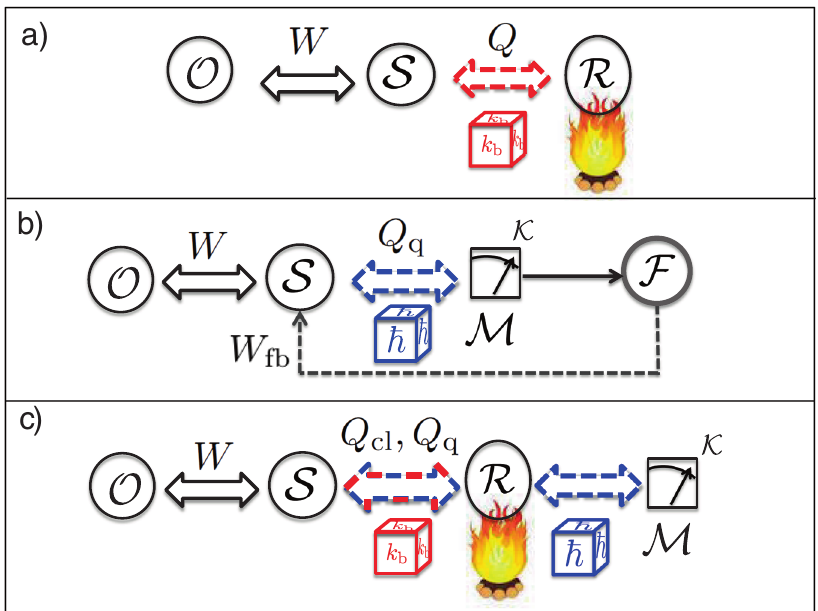
Fig. 1 a The scenery of thermodynamics: A system S deterministically exchanges work W with an operator/battery O and stochastically exchanges heat Q with a bath/reservoir R . The system ’ s evolution is randomly perturbed by the thermal bath, which is symbolized by the dice k b . b “ Thermodynamics without bath ” : a driven quantum system undergoes projective quantum measurements at discrete times. Here the evolution of the system is randomized by the measuring device M , which is symbolized by the dice ħ . Energetic fl uctuations induced by quantum measurement are identi fi ed with some heat exchange of quantum nature Q q . In the case of a stabilizing protocol, this quantum heat exchange must be exactly compensated by the work W fb performed by a feedback source F . c Quantum open systems: a driven system S is coupled to a Markovian reservoir R , itself monitored by a measuring device M . The exchanges of heat can be of classical ( Q cl ) or of quantum nature ( Q q ), and respectively correspond to the classical and quantum energy fl uctuations induced by the coupling to the